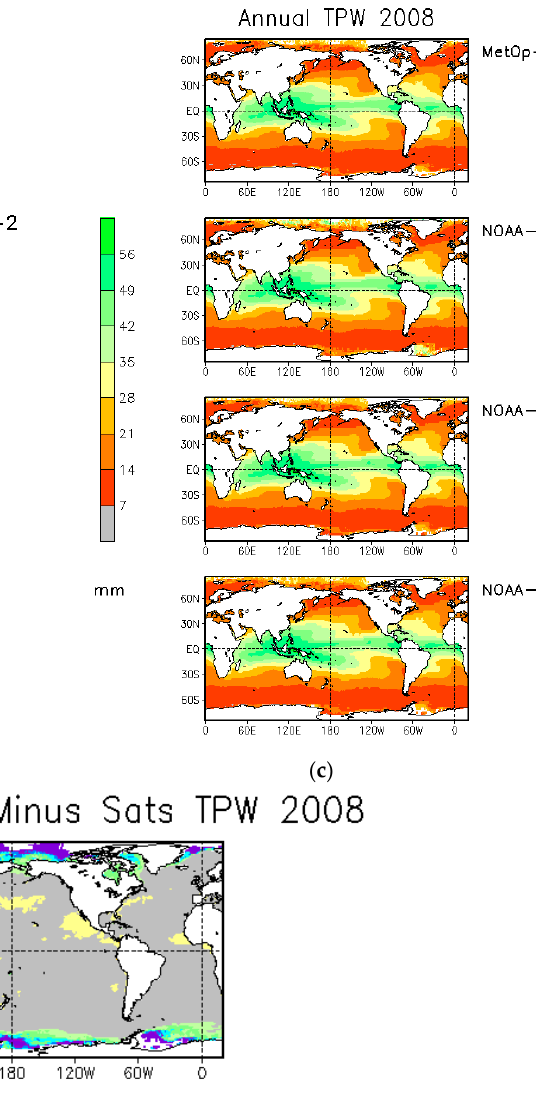
Figure 6. Time series of monthly mean TPW (mm) for each satellite in the HBC and MERRA-2 for the band between 60°S and 60°N. 3.4. Land Surface Temperature (LST) For land surface temperature (Figure 7), the overall patterns between the HBC and MERRA-2 are similar. However, the satellite estimate is lower over high-altitude locations, including Antarctica, Greenland, and the Himalayas, which may be attributed to improper handling of the highly variable land emissivity over these complex surfaces in the MSPPS algorithm. The satellite estimates also tend to be cooler over much of the high latitude Northern Hemisphere land. MERRA-2 estimates are slightly cooler over much of the tropics. There are subtle differences between the four different satellites shown, and these are most likely explained by the overpass